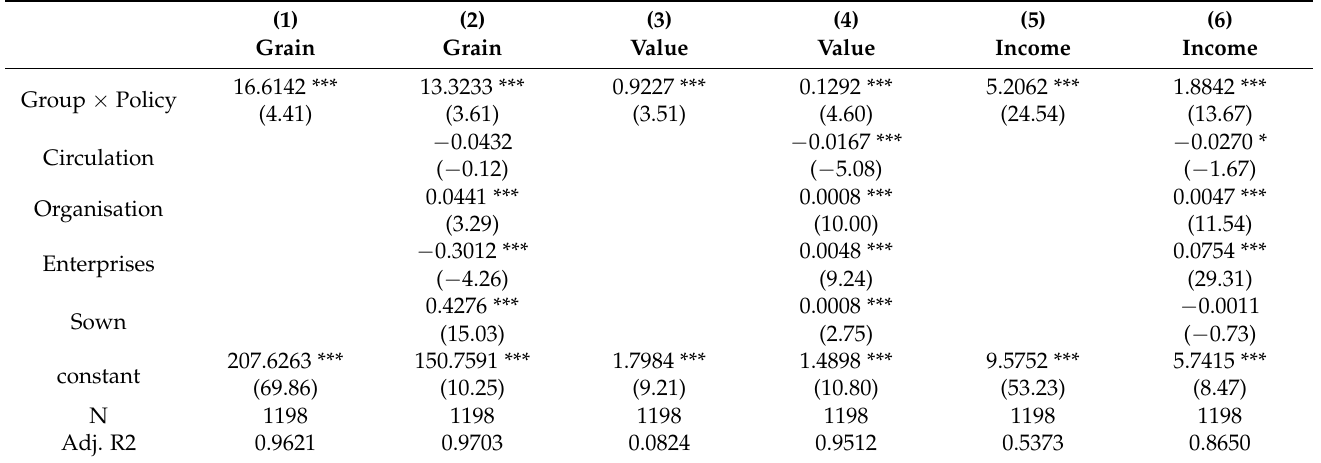
Table 5. Results of the PSM-DID analysis of rural agricultural